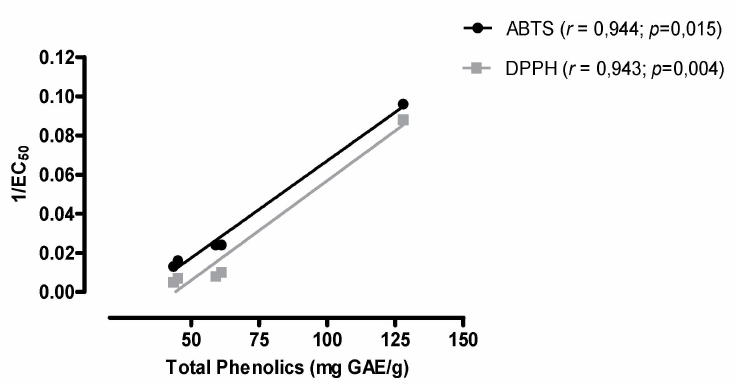
Figure 3. Correlation among the total phenolic content and the antiradical activity DPPH and (cid:4) + antiradical activity ABTS of ethanol extracts and methanol fraction of P. gounellei